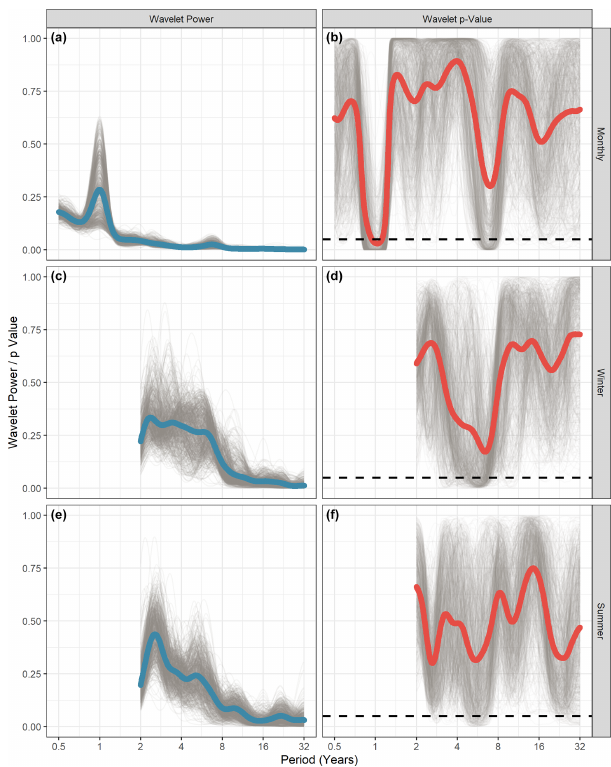
Figure 4. As in Fig. 3 but for catchment rainfall